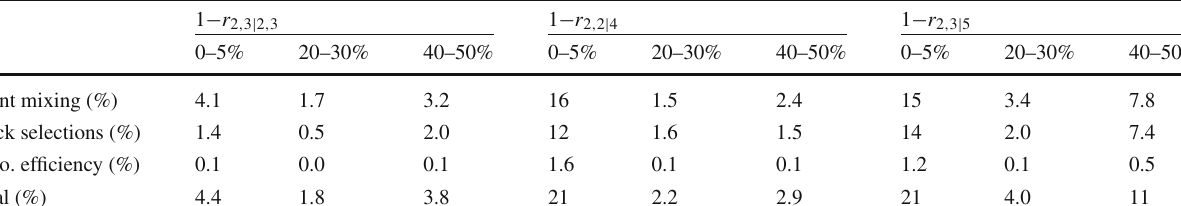
Table 4 Systematic uncertainties in percent for 1 − r 2 , 3 | 2 , 3 , 1 − r 2 , 2 | 4 and 1 − r 2 , 3 | 5 at η = 1 . 2 in selected centrality